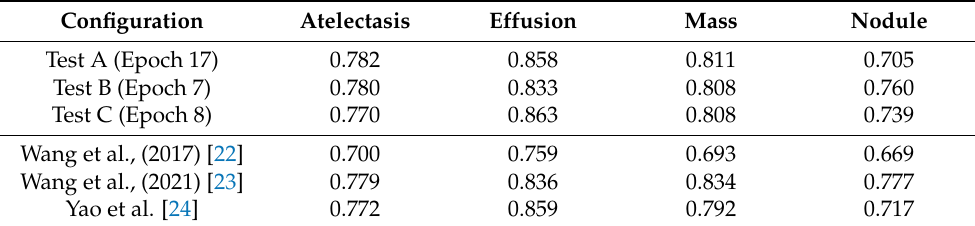
Table 2. Comparison of achieved AUC-ROC scores for ChestX-ray14 holdout test subset to other published works using similar techniques.